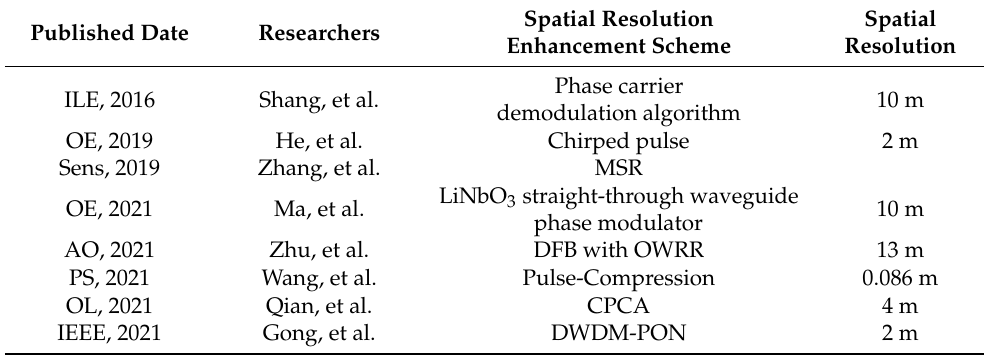
Figure 12. ( a ) Experimental setup. ( b ) The result of spatial resolution measurement [54]. Table 3. Research progress on for spatial resolution enhancement.